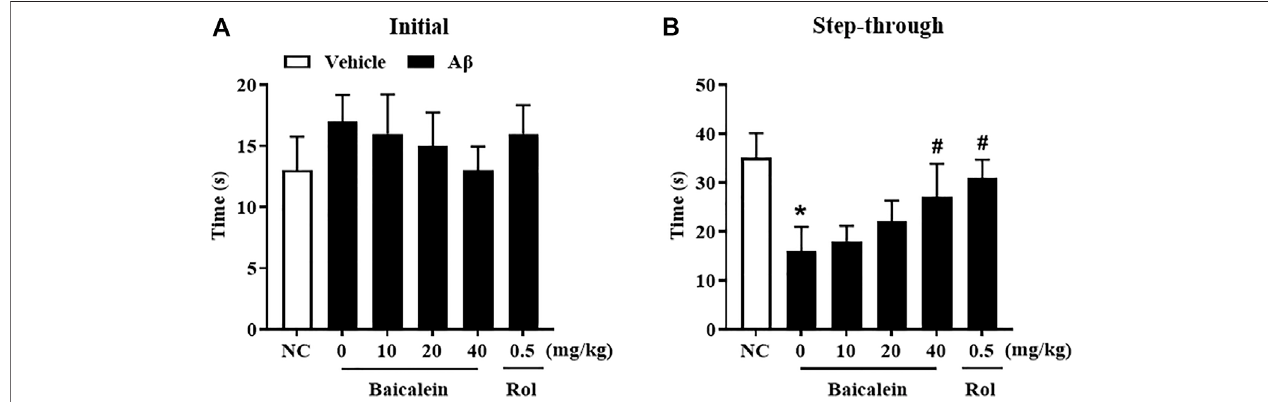
FIGURE 4 | Baicalein ameliorated memory behavior of A β -treated mice in the shuttle box test. (A) Initial timeto the black box without receiving stimulation, and (B) time to the black box after electric shock stimulation were ameliorated by baicalein treatment in A β -treated mice. All values were expressed as mean ± SEM ( n (cid:2) 6). * p < 0.05 vs. NC mice; # p < 0.05 vs. A β -treated mice.